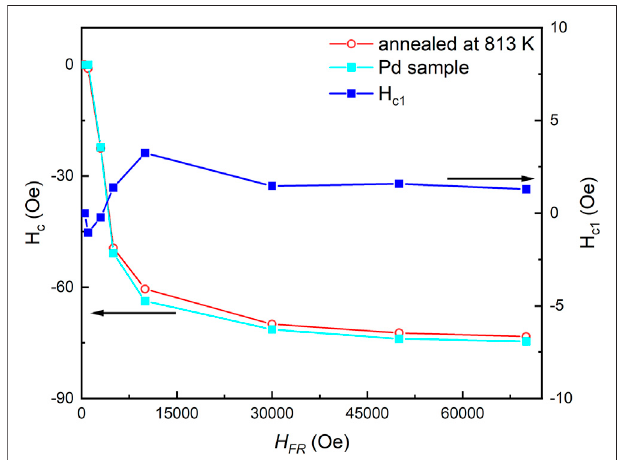
FIGURE 4 | The net coercivity H c and H c1 as a function of scan fi eld ranges H FR used in hysteresis loop